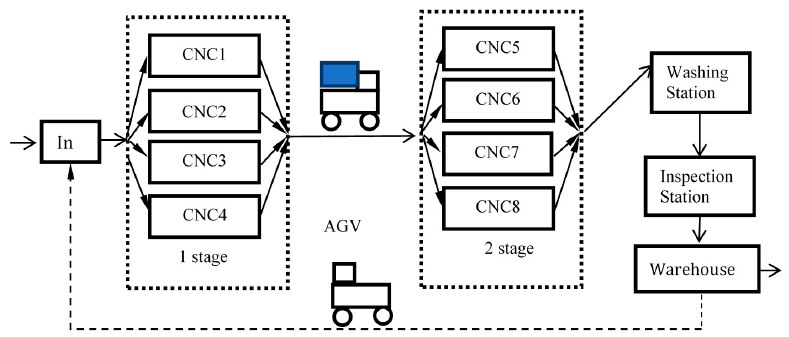
Figure 2. The schema of Flexible Manufacturing System (FMS) with AGV transport.